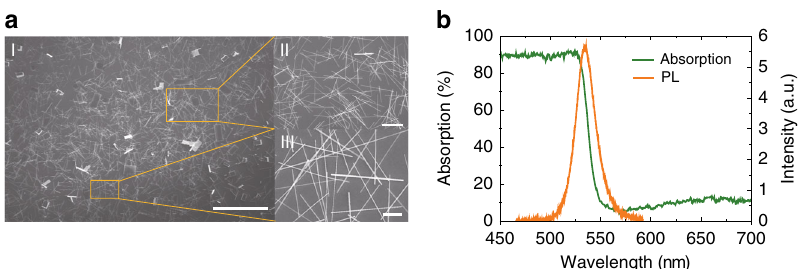
Fig. 1 The synthesized MAPbBr 3 perovskite microrods. a The top-view SEM image of MAPbBr 3 microrods. The length of scale bar of I, II, and III are 100, 20, and 5 μ m, respectively. b The absorption (green line) and photoluminescence (orange line) of MAPbBr 3